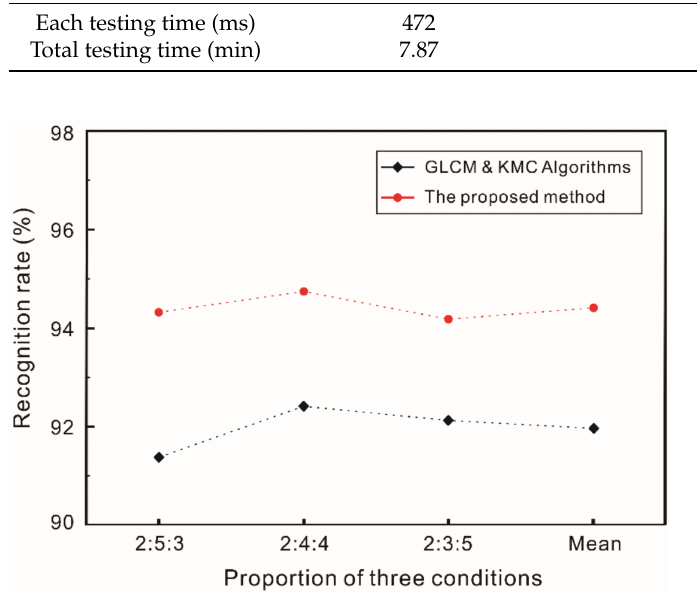
Figure 14. Diagram of the algorithm comparison.